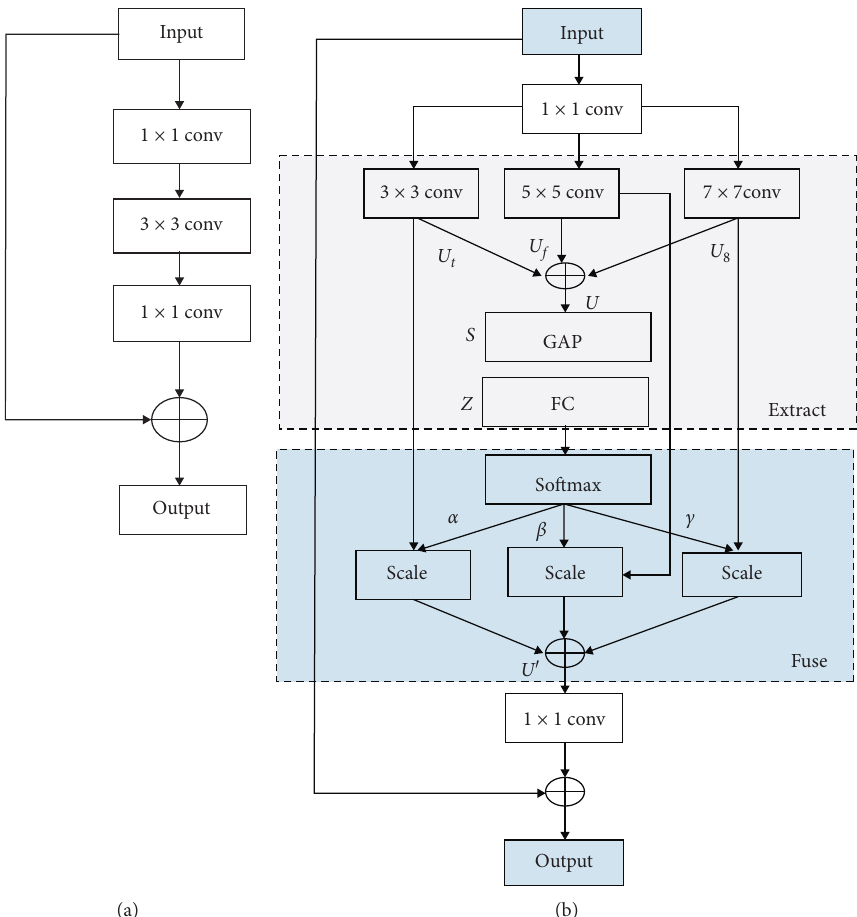
Figure 4: Structure diagram of Multiscale Residual Fusion Module. (a) Original residual structure. (b) Multiscale residual